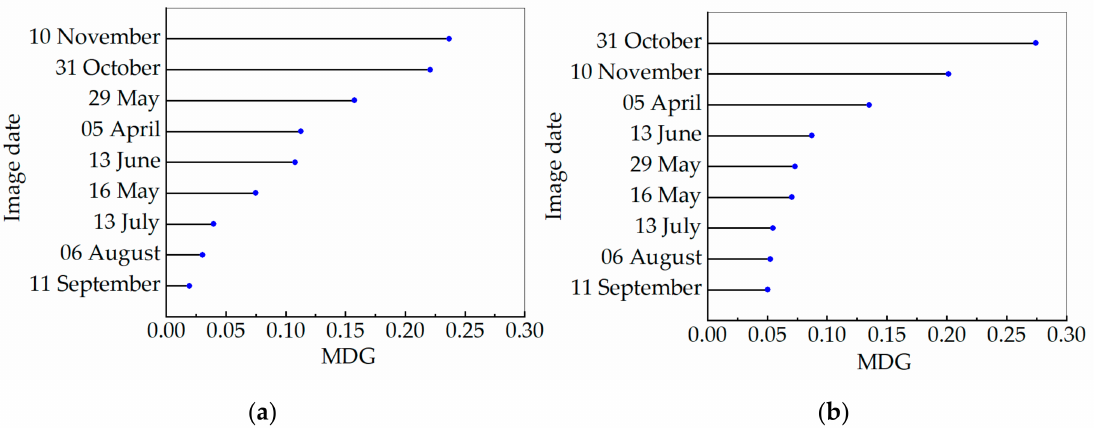
Figure 9. Importance of image dates. ( a ) Model 1 and ( b ) Model